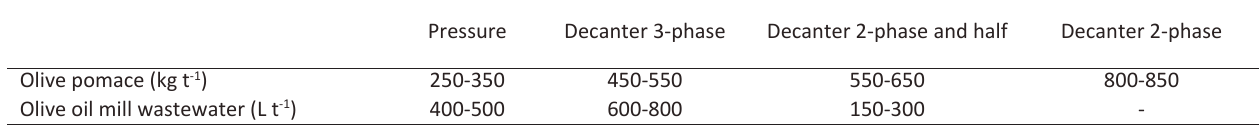
From Di Giovacchino and Preziuso,